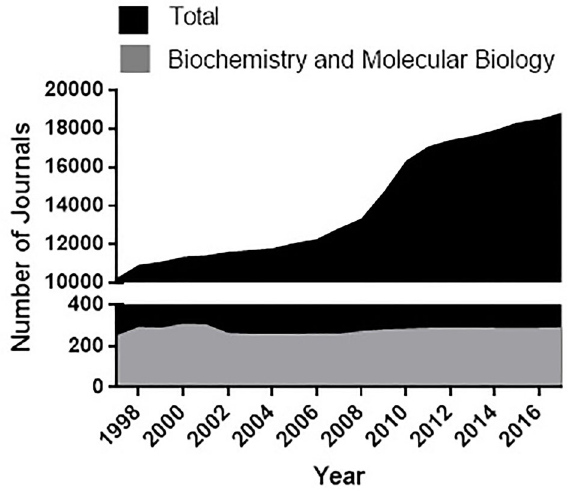
Figure 1. The number of academic journals has increased signi fi cantly over the last twenty years. Data were collected